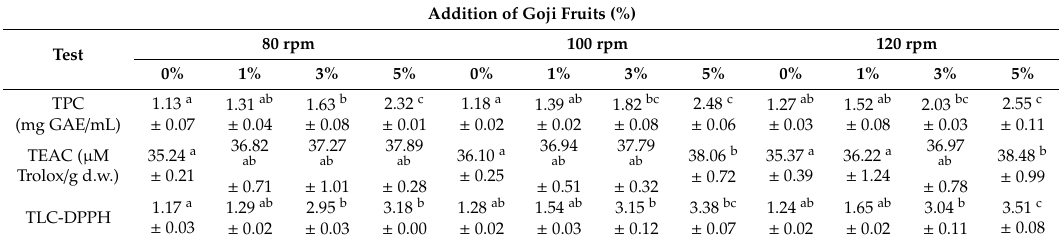
Table 1. Total content of polyphenolic compounds (TPC), Trolox equivalent antioxidant capacity (TEAC) and results of TLC-DPPH test of instant corn gruels enriched with goji fruits extruded at various screw speeds (n = 3; mean ± SD). The TLC-DPPH assay shows the antiradical activity of analyzed extracts (plate scanned after 30 min) in relation to the activity of 0.1 mg / mL rutin solution (activity of rutin solution equal to “1”).